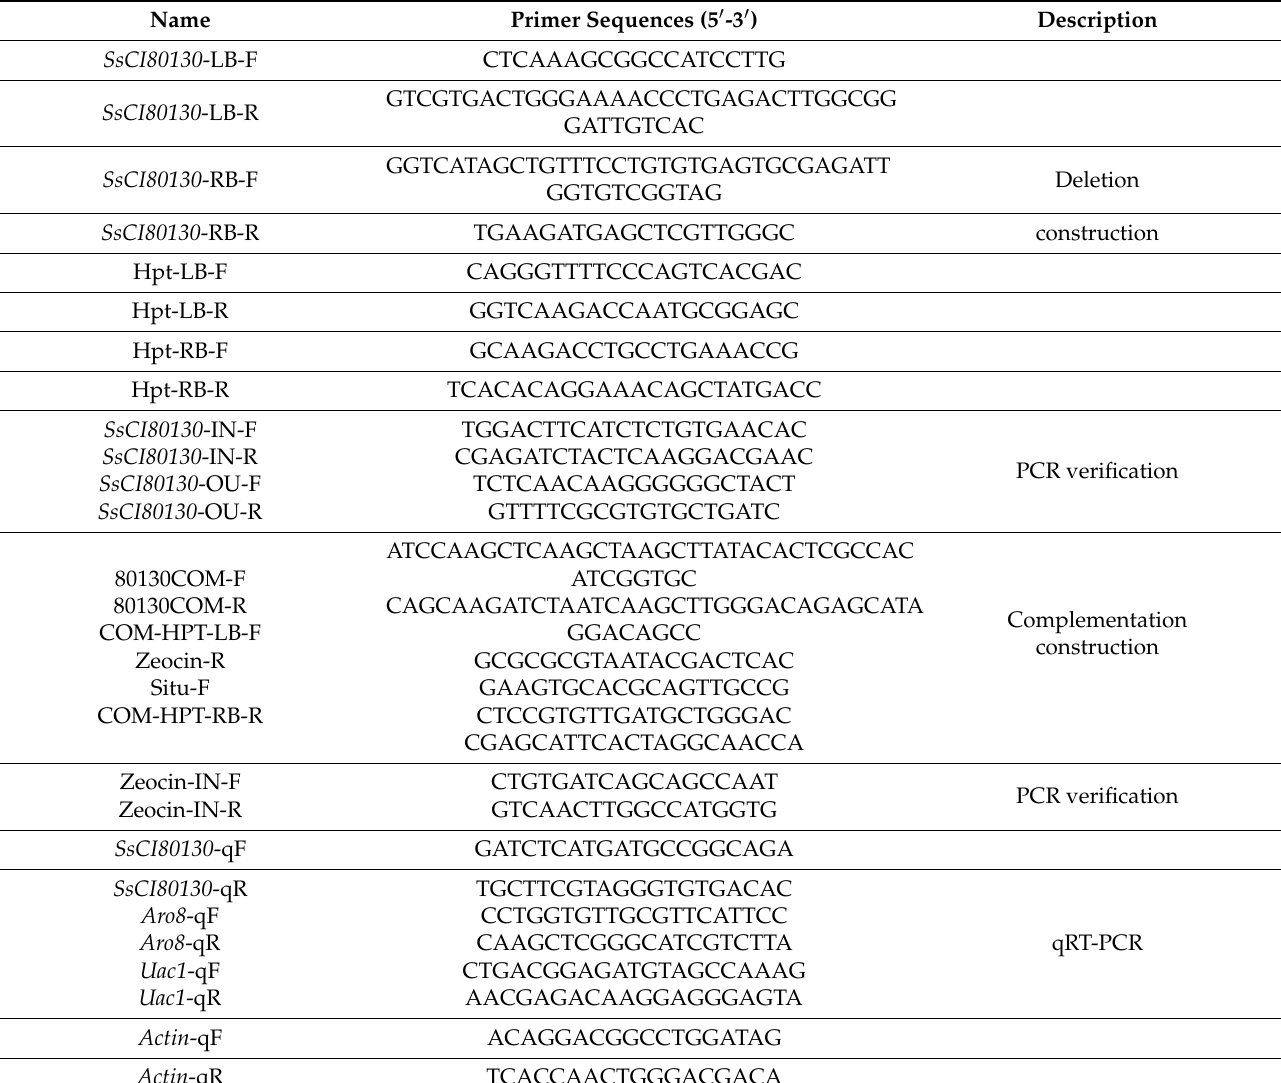
Table 1. Primers used in this